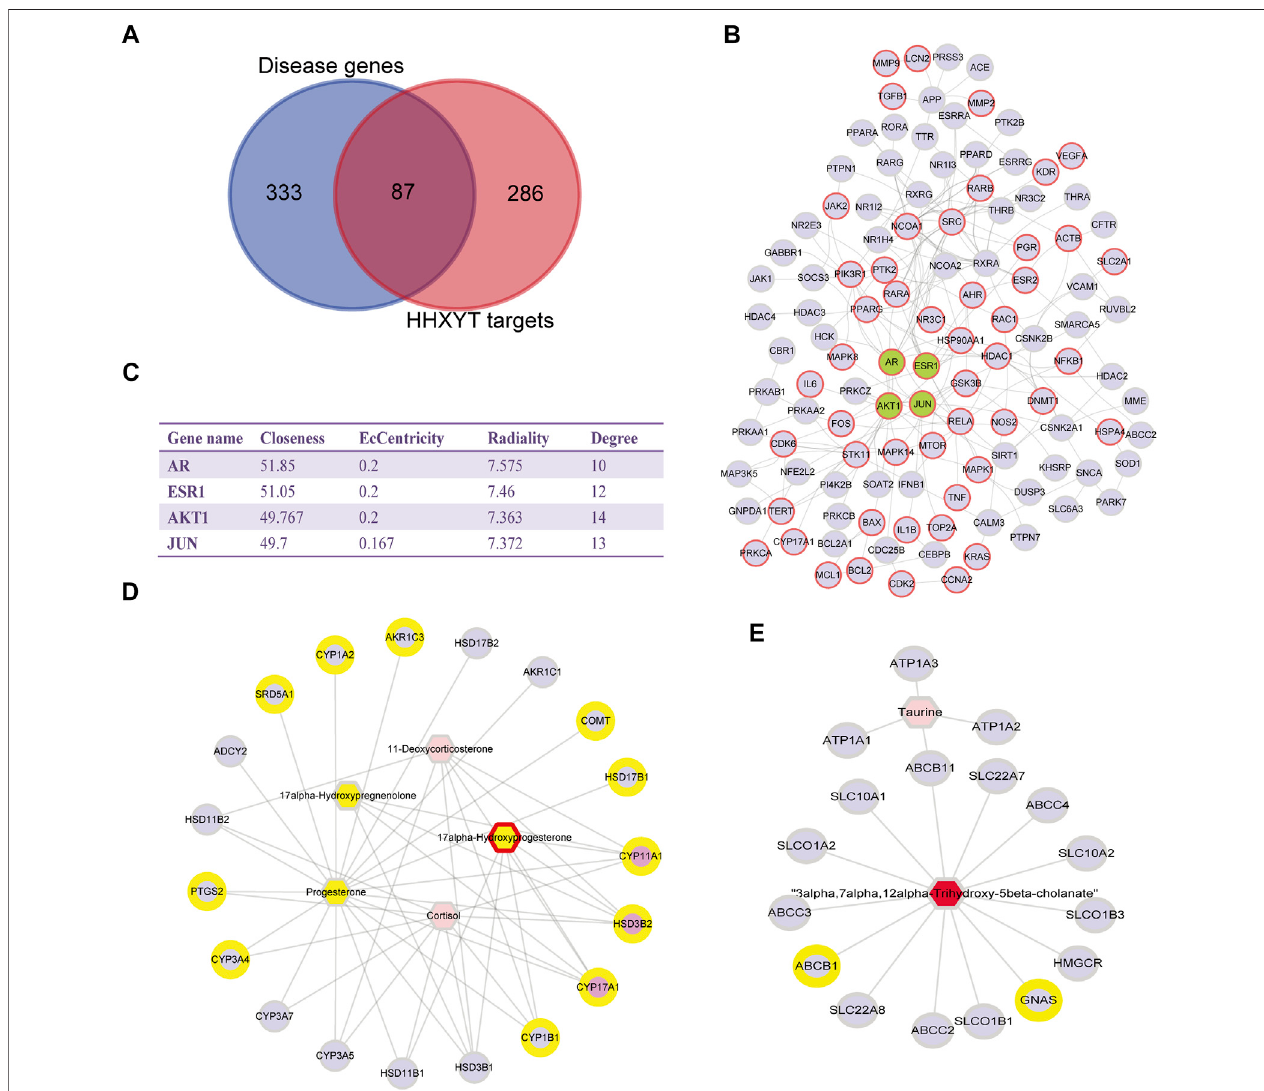
FIGURE 7 | Network pharmacological analysis for HHXYT ’ s putative targets and integrated analysis of metabolic modules. (A) The intersection between HHXYT ’ s putative targets and MGH disease genes from GeneCards. (B) HHXYT ’ s putative target network, where the nodes with red borders are MGH disease genes and the green nodes are central nodes with the highest global centrality. (C) Global (Closeness, EcCentricity, Radiality) and local centrality measures (Degree) of the four central nodes in the target network. Metabolite-gene networks for the fi rst (D) and second metabolic module (E) affected by HHXYT, respectively. Hexagons were endogenous differential metabolites identi fi ed from the metabolomics analysis and circles were HHXYT ’ s target and genes. Yellow represented in MGH disease conditions, while red represented in HHXYT-H. Pink circles were the hub genes of the network.